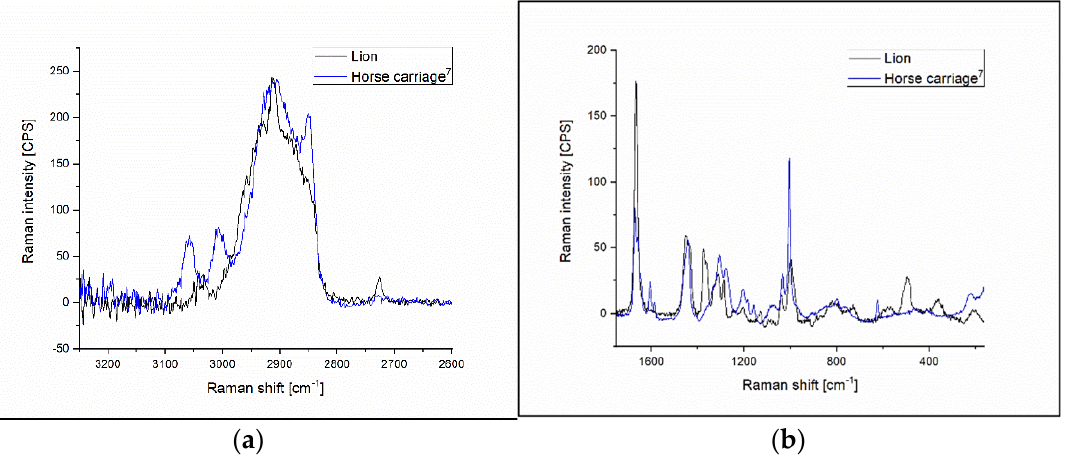
Figure 10. ( a ) Raman spectra of Lion (represents latex ligature group) and Horse carriage 7 (represents latex-free ligatures) elastomers at 3250 cm − 1 –2600 cm − 1 region. ( b ) Raman spectra of Lion and Horse carriage 7 elastomers at the range of 1750 cm − 1 –165 cm − 1 .